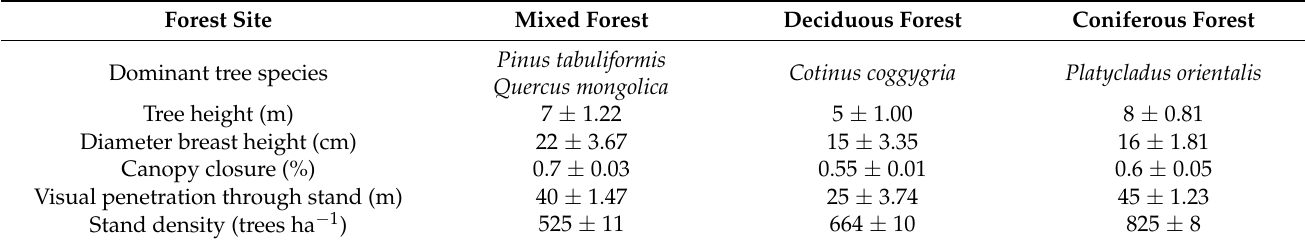
Table 1. Forest characteristics in forest sites.